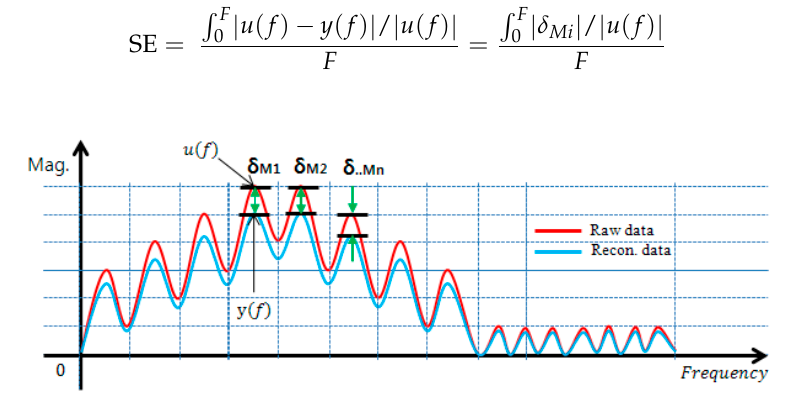
Figure 15. Concept of spectrum error (SE).